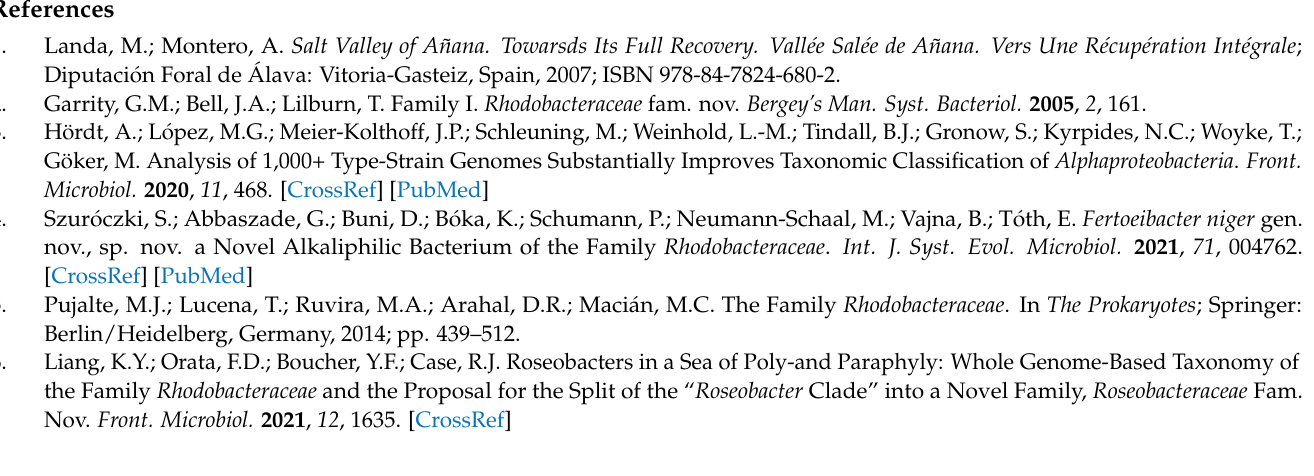
Table S2: Presence and absence of subsystems in strain ASV31 T compared to its closest relatives. Table S3: CAZyme types present in ASV31 T